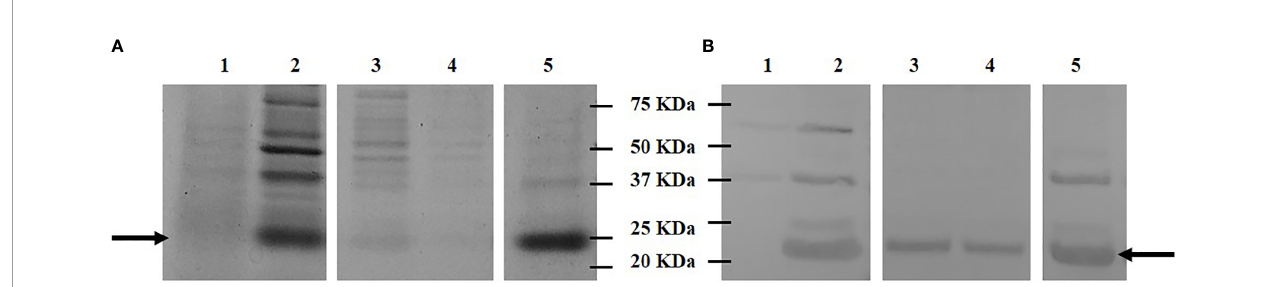
FIGURE 2 | Puri fi cation of TrxPI from ISF by af fi nity chromatography and isolation from IB. Analysis of TrxPI fractions by (A) SDS-PAGE (12.1 % T, 6.0 % C, 1 mm, under reducing conditions, stained with Coomassie Brilliant Blue R-250) and (B) WB revealed with a rabbit polyclonal serum to Thioredoxin as primary antibody. In (A, B) , lane 1 corresponds to total lysate of transformed E coli strain GI724 before induction, lane 2: total lysate of transformed E coli strain GI724 after induction, lane 3: puri fi ed TrxPI from ISF, lane 4: TrxPI biotinylated, lane 5: TrxPI from IB. Arrows indicate the electrophoretic mobility of TrxPI.